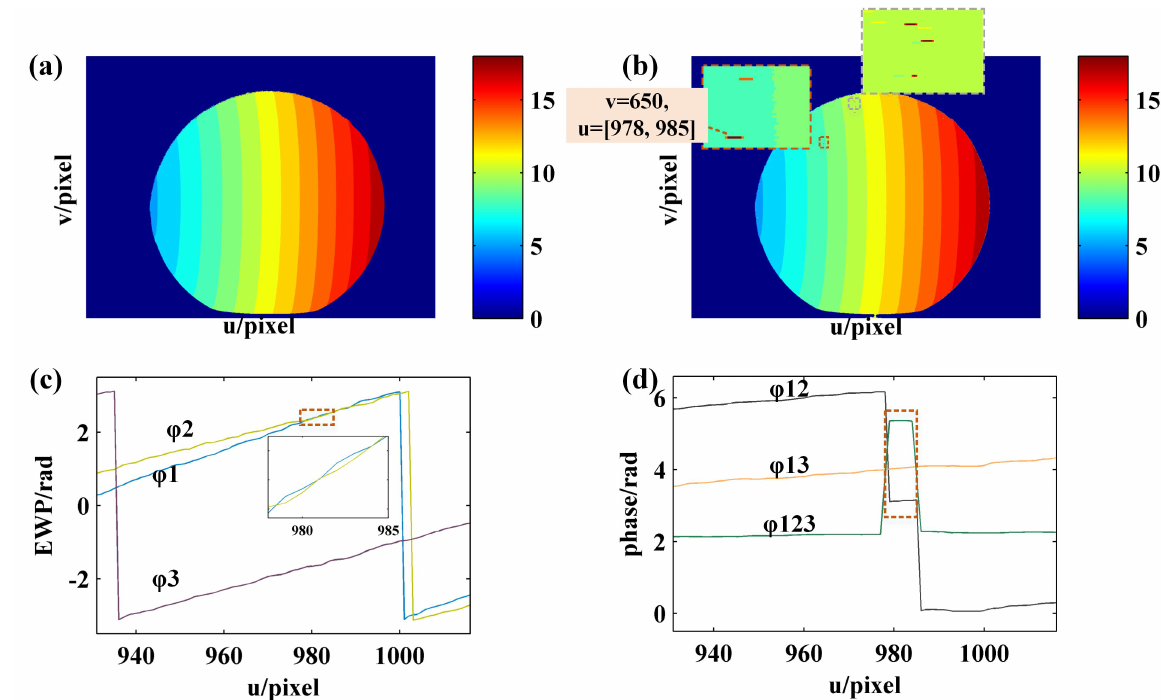
Figure 14. Comparison results of the sphere fringe orders: ( a ) fringe order map obtained by proposed method; ( b ) fringe order map obtained by three-frequency phase-shift method; ( c , d ) are, respectively, the EWP and equivalent phase of row 650 calculated for three-frequency phase-shift method.